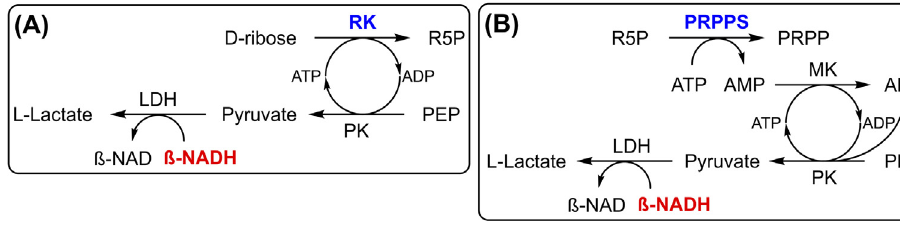
Figure 3. Schemes for assaying the enzymatic activities of (A) ribokinase and (B) PRPP synthetase